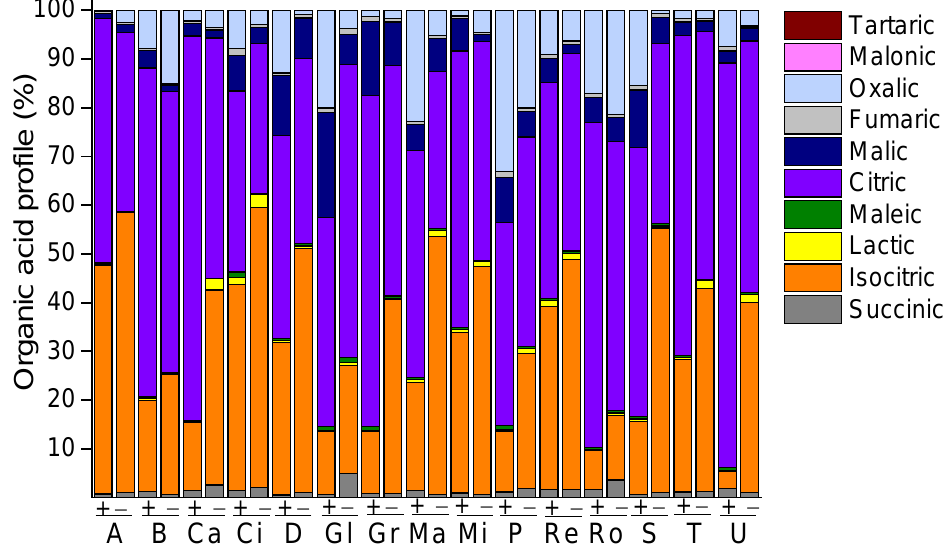
Figure 4. Organic acid profile in root exudates of fifteen eucalypt species grown under low ( − ) and sufficient (+) phosphorus concentrations. Species abbreviations: A— E. acmenoides , B— E. brassiana,